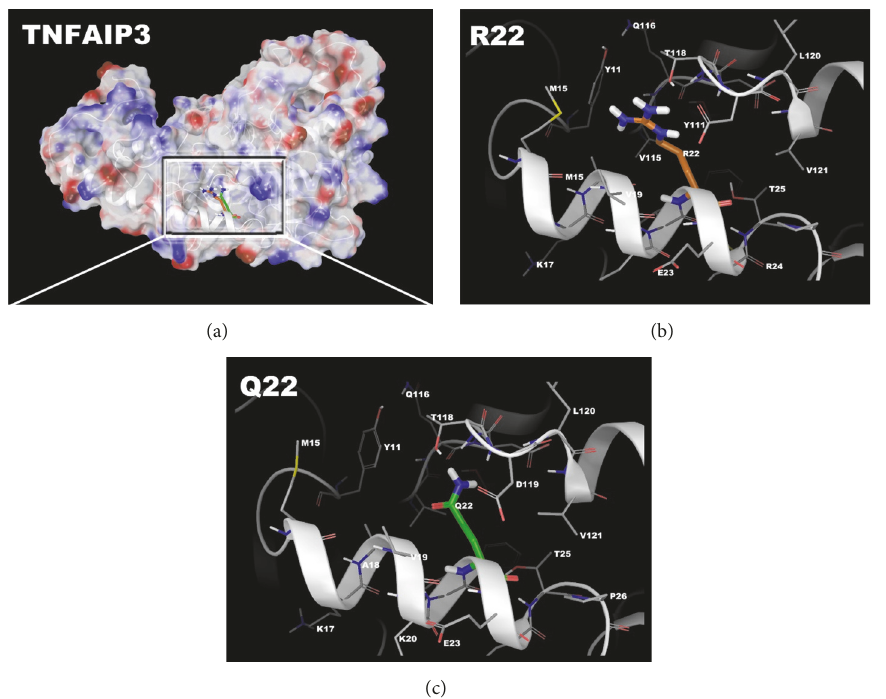
Figure 2: TNFAIP3 molecular model for full-length human sequence consisting of 791 amino acids and the variant p.R22Q. (a) Full-length model for the entire TNFAIP3 structure with electrostatic mapping onto the ribbon structure is shown. The density map is cut away to reveal where Arg22 and Gln22 play a role in the interaction between the helix and the loop. (b) Zoom-in on the wild type for the Arg22 residue from the full-length model to better show the interacting residues. (c) Zoom-in on the region around the Gln22 variant, showing nearby residues. All protein residues shown in licorice rendering and using standard element coloring (C-gray, O-red, N-blue, H-white, and S-yellow) except for the highlighted residues (Arg22: orange carbons, Gln22: green carbons).